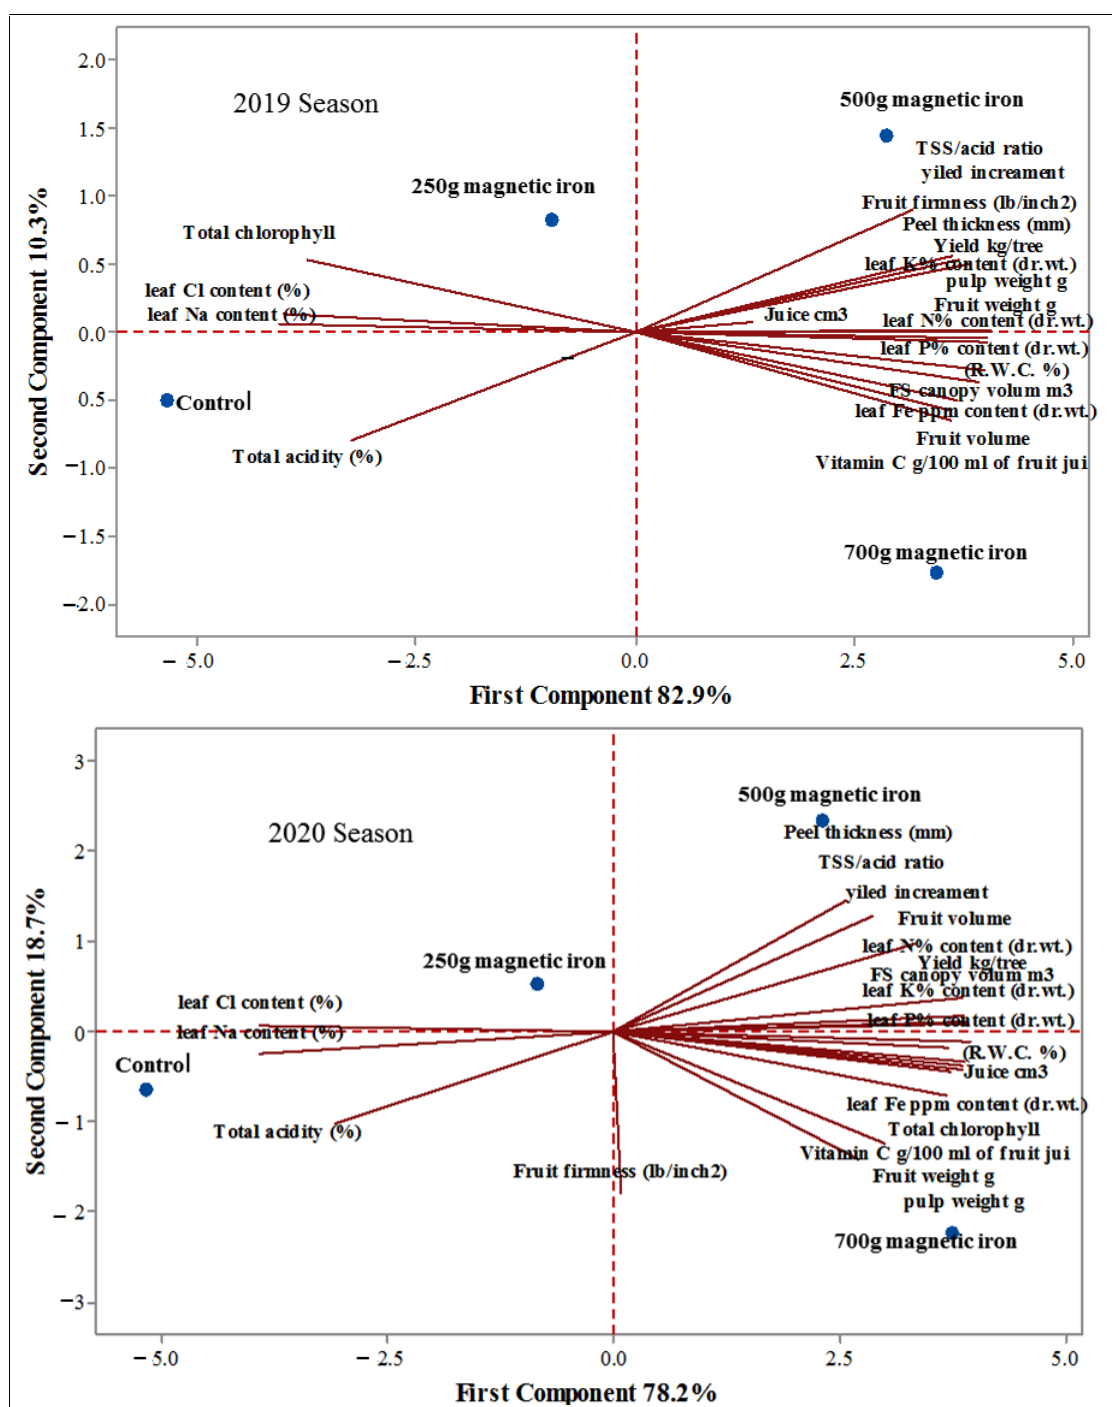
Figure 7. Biplot extracted by principal component analysis (PCA) among parameters studied based on different amounts of effect of magnetic iron application in 2019 and 2020 seasons: control, 250 g of magnetic iron tree −1 , 500 g of magnetic iron tree −1 , and 700 g of magnetic iron tree −1 : Yield kg.tree −1 , yield increment; Fruit weight, g; Fruit volume, fruit firmness (lb/inch 2 ); pulp weight, g; juice, cm 3 ; canopy volume, m 3 ; leaf N% content, dr.wt.; leaf P% content, dr.wt.; leaf K% content, dr.wt.; leaf Fe ppm content, dr.wt.; leaf Na content, %; leaf Cl content, %; total chlorophyll, R.W.C.%; total acidity, %; TSS/acid ratio, Vitamin C g/100 mL of fruit juice; and peel thickness, mm. Table 1. Results of principal component analysis (PCA) of effect of magnetic iron application on fruit chemical properties of ‘Chinese’ mandarin trees during 2019 and 2020 seasons.